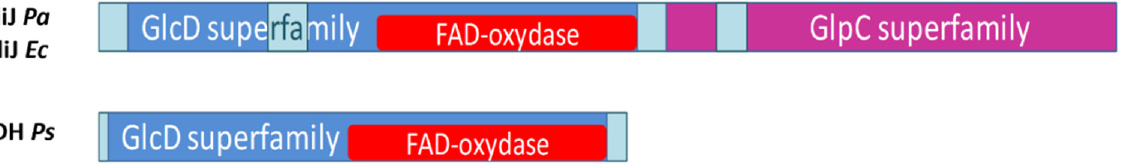
Figure 3. Domain structure of YdiJ of P. ananatis (Pa) and E. coli (Ec) and D2HGDH of P. stutzeri A1501 (Ps).